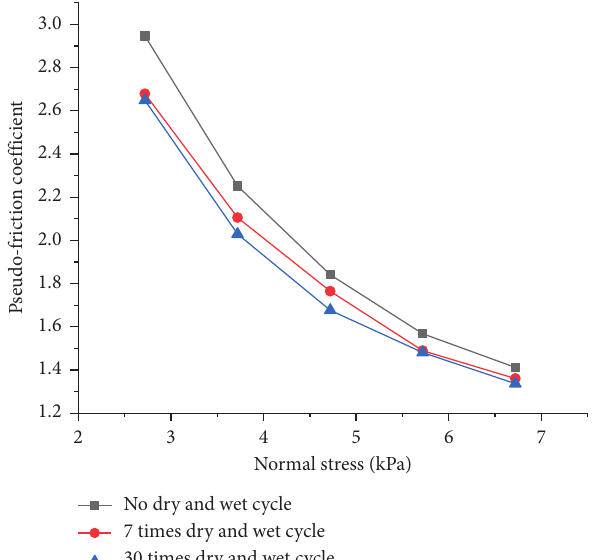
Figure 14: The apparent friction coefficient-normal stresses curve for different dry-wet cycles with water content of 14%.